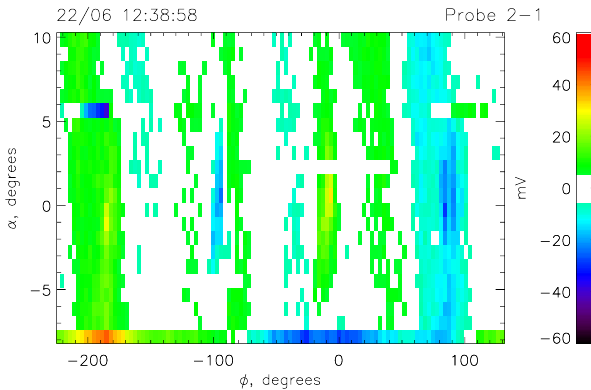
Fig. 10. Map of the disturbances of the potentials of EMMA probes 1 and 2 given as V 1 − V 2 in (φ,α) coordinates. Probe 1 is parallel to B at φ = − 180 ◦ , and probe 2 is parallel to B at φ = 90 ◦